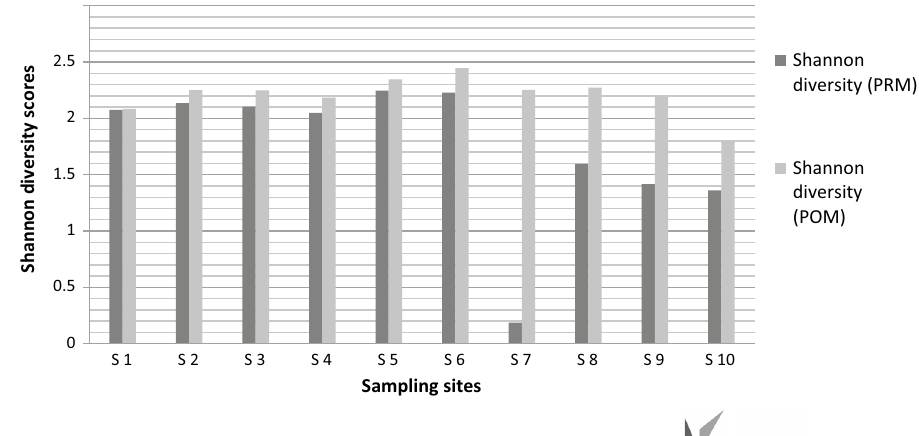
Fig. 4 Shannon diversity (H ′ ) during pre-monsoon (PRM) and post-monsoon season